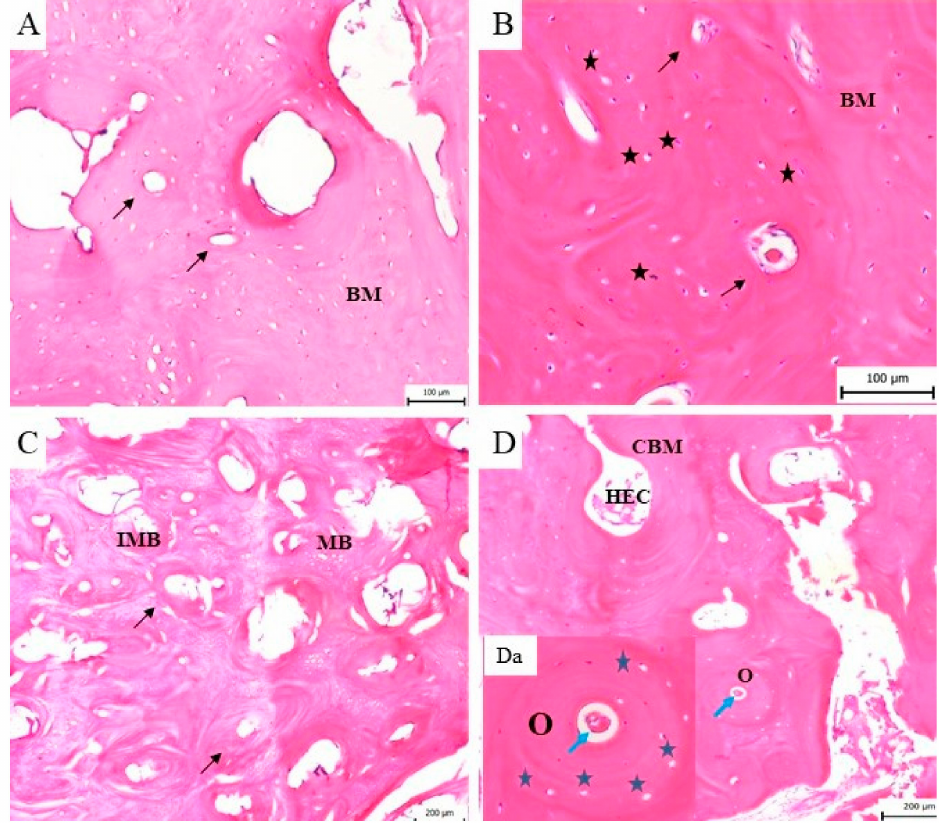
Figure 9. The histological evaluation of the bone formation. ( A ) Three months from implantation a new, immature bone with the bone matrix (BM) and typical cement lines (black arrow) is shown. ( B ) Four months after implantation the woven bone with a high number of osteoblasts (black asterisk) in the bone matrix (BM) and cement lines (black arrow) is still observable. ( C ) Five months after surgery, the bone matrix consists of area with immature, woven bone (homogeneous and fibrous structure) with cement lines (black arrow). In this sample differences between immature (IMB) and mature (MB) bone tissue are visible. ( D ) Six months after implantation the mature bone is fully developed and characterized by typical bone structures such as osteocytes, osteons (O), a cavity with the bone marrow (CBM) and haematopoietic cells (HEC) in the mineralised bone matrix. ( Da ) The osteon (O) is a structure of the mature bone, where a typical osteocyte (blue asterisk) arrangement with the Haversian system (blue arrow) in the middle is